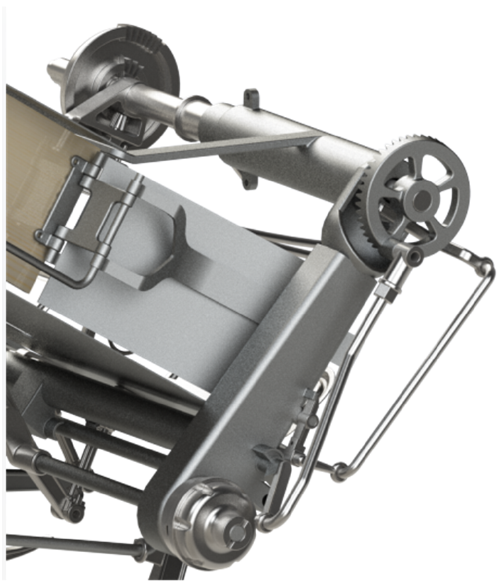
Figure 23. Knotting-system gearbox.